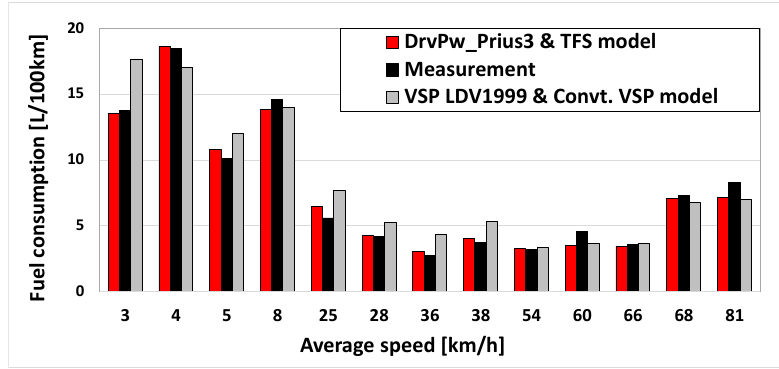
Figure 8. Fuel consumption prediction validation among DrvPw Prius 3 and TFS model method, Figure 8 . Fuel consumption prediction validation among 𝐷𝑟𝑣𝑃𝑤 (cid:3017)(cid:3045)(cid:3036)(cid:3048)(cid:3046)(cid:2871) 𝐚𝐧𝐝 𝑇𝐹𝑆 𝑚𝑜𝑑𝑒𝑙 method, measurement data, and VSP LDV 1999 and Convt . VSP model method. measurement data, and 𝑉𝑆𝑃 𝐿𝐷𝑉1999 and 𝐶𝑜𝑛𝑣𝑡.𝑉𝑆𝑃 𝑚𝑜𝑑𝑒𝑙 method.